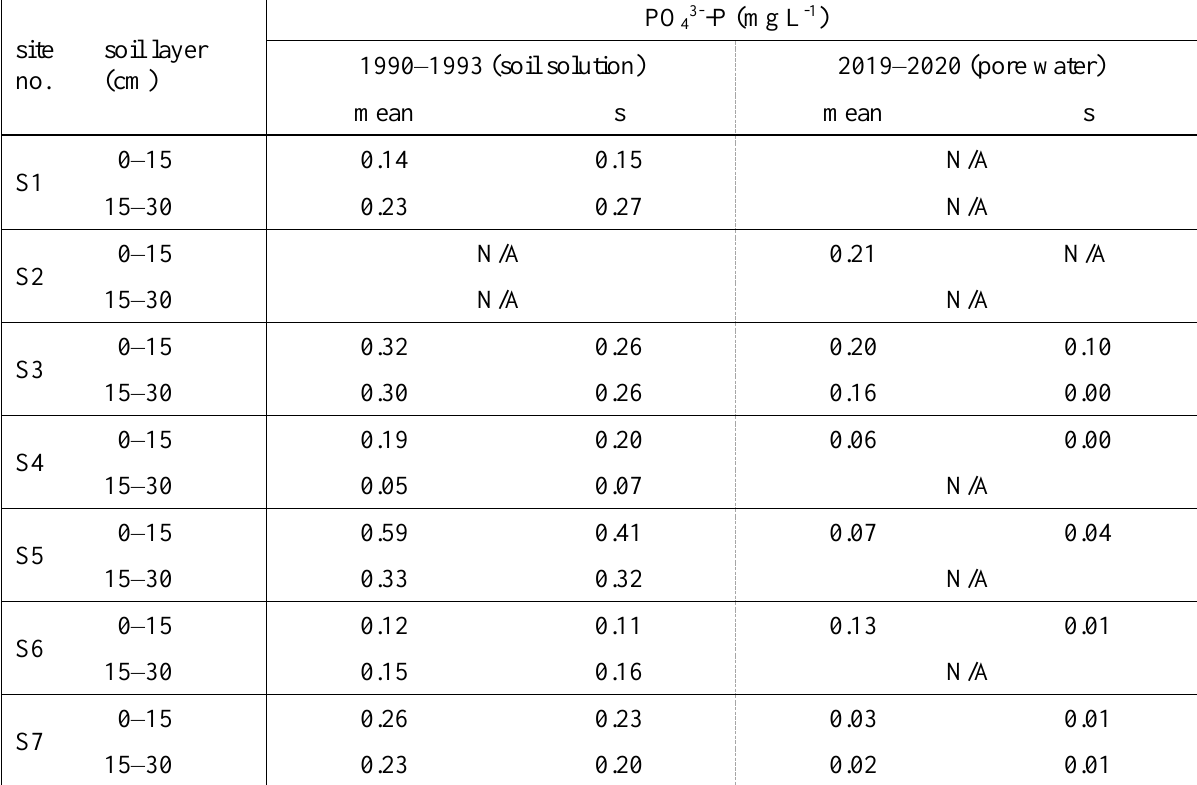
Table A5. Soil water PO 43- - P at the individual sampling sites, from the initial examination in 1990–1993 (Gebhardt & Knabke 1994) and the follow-up examination in 2019–2020. N/A = data not available.